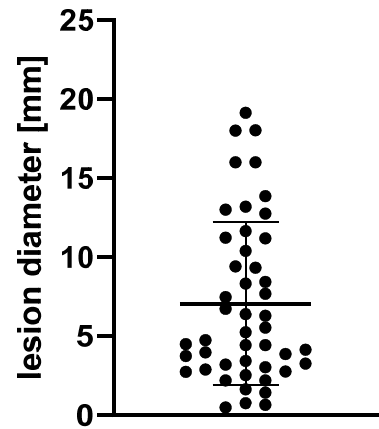
Figure 2. Diameter of analyzed lesions.